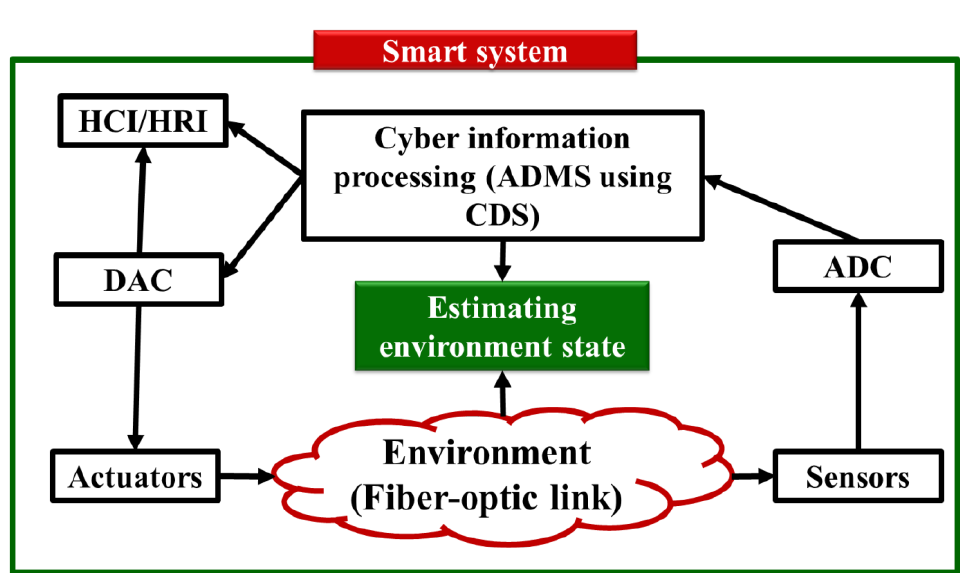
Figure 1. Intelligent system architecture using a cognitive dynamic system (CDS) as the cyber-physical system (CPS) and an autonomous decision-making system (ADMS). HCI: Human – computer interaction, HRI: Human – robot interaction, ADC: Analog-to-digital converter, DAC: Digital-to-analog converter.